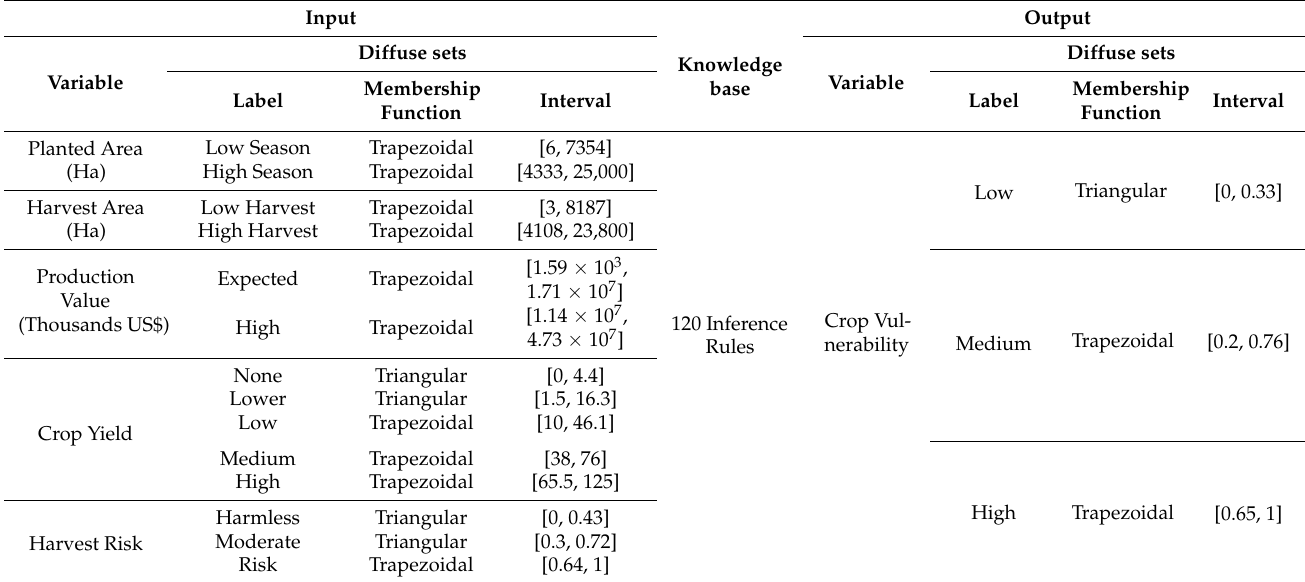
Table A3. Crop vulnerability model: fuzzy sets and operation intervals.